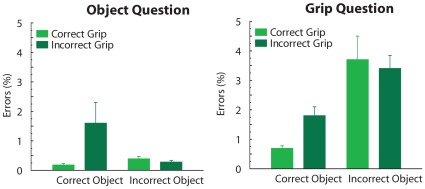
Behavioral results.Error rates in response to object questions (left graph) or to grip questions (right graph). Bars on the left represent responses to action sequences representing grasping of the correct object, bars on the right represent responses to action sequences representing grasping of the incorrect object. Light bars represent responses to action sequences representing a correct grip, dark bars represent responses to action sequences representing an incorrect grip.